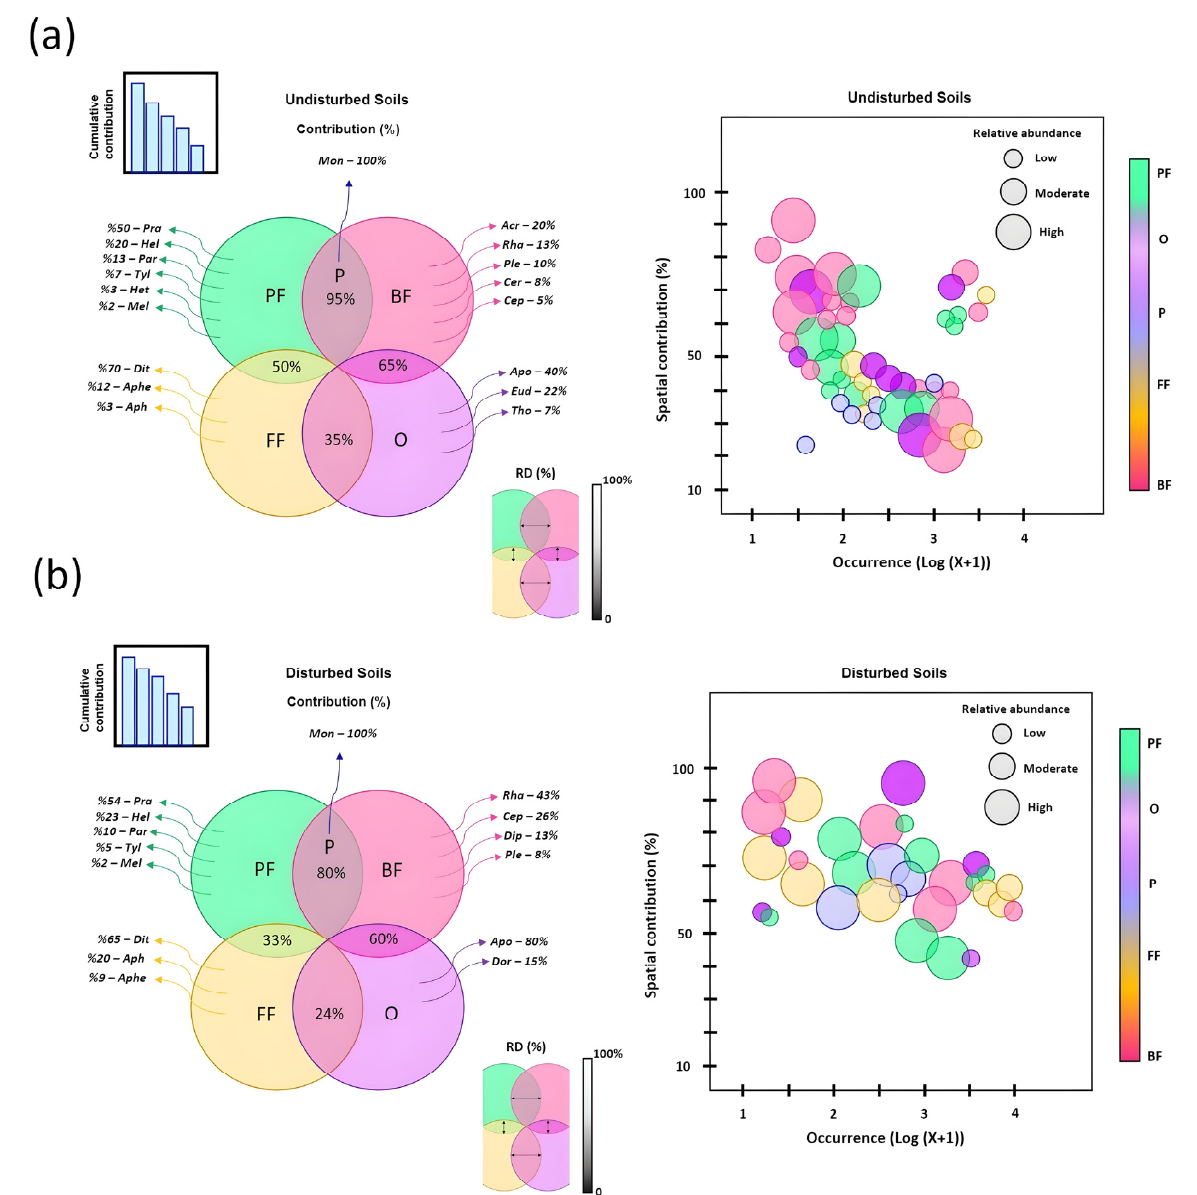
Figure 8. Nematode contribution patterns to agricultural wheat soil health. ( a ) Spatial contribution percentage of all soil nematode feeding types in undisturbed cereal soils. ( b ) Spatial contribution percentage of all soil nematode feeding types in disturbed cereal soils. The unidimensional plot represents the projected contribution values according to the ANOSIM and SIMPER analyses. These values were plotted in a multidimensional spatial bubble plot using a predicted model based on nematode abundance in each contribution pattern. Relative distance (RD) was calculated and computed between nematode trophic groups. The plots were generated using BioPython matplotlib library via Yellowbrick machine learning module [55] and sviewgui PyQt-based GUI packages [56] in PyCharm API.